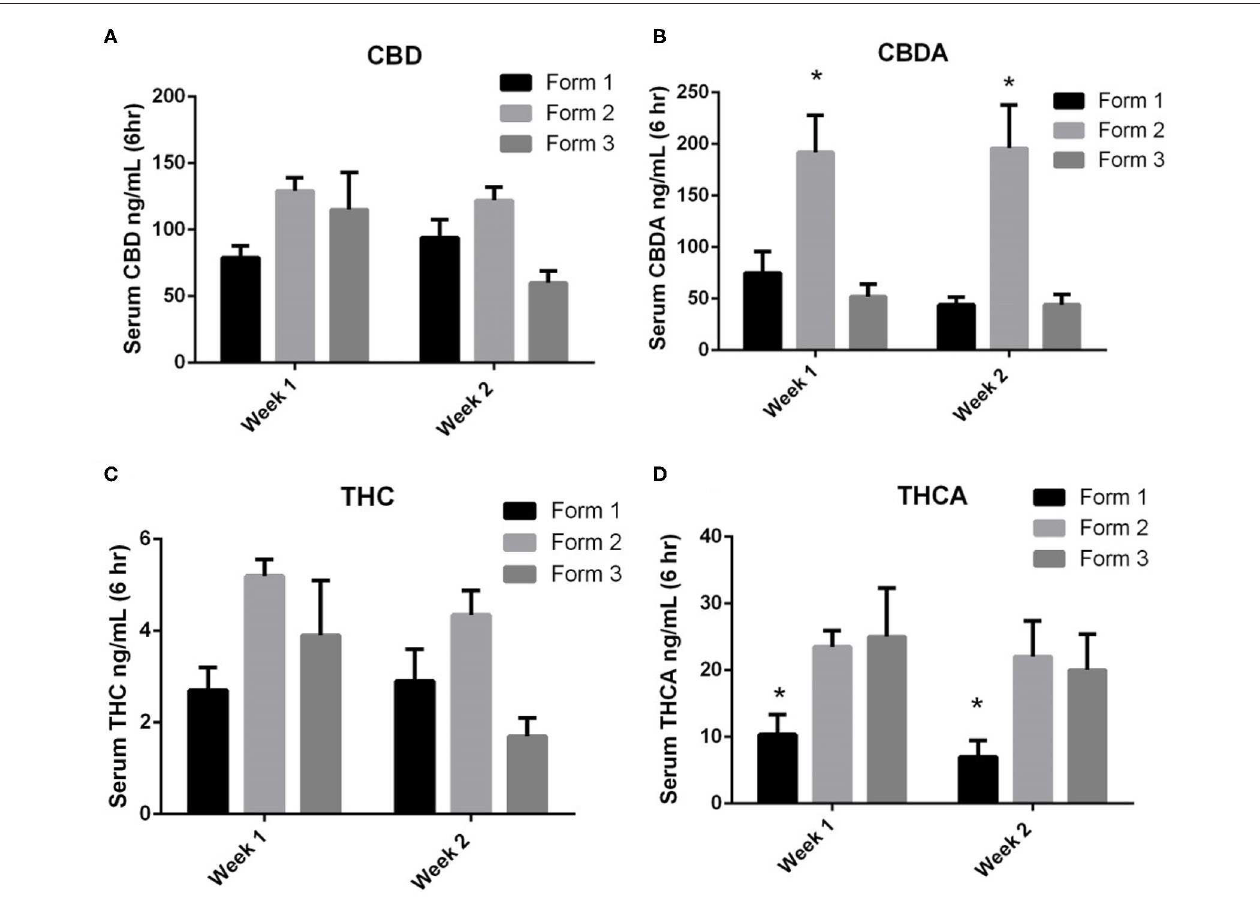
FIGURE 3 | One- and two-week serum cannabinoids concentrations (mean and SEM) 6h after morning dosing when using Form 1, Form 2, or Form 3 for oral dosing. (A) Serum CBD concentrations. No significances noted between formats or times; (B) serum CBDA concentrations. *Indicates a significant increase in serum CBDA concentrations for Form 2 as weeks 1 and 2 when compared to Form 1 and Form 3 ( p < 0.01); (C) serum THC concentrations. No significances noted between formats or times; and (D) serum THCA concentrations. *Indicates a significant decrease in THCA with Form 1 when compared to Form 2 and Form 3 at both weeks 1 and 2 ( p < 0.01).